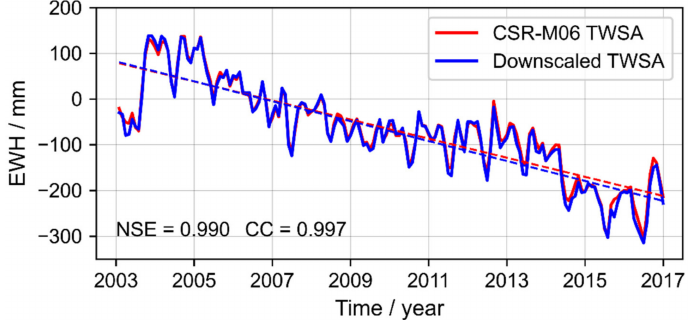
Figure 10. Time series of TWSA before and after downscaling in Guantao County. (Notice that the time series is the average signal of the small blue rectangle in Figure 9: 115.0 ◦ –115.5 ◦ E, 36.5 ◦ –36.75 ◦